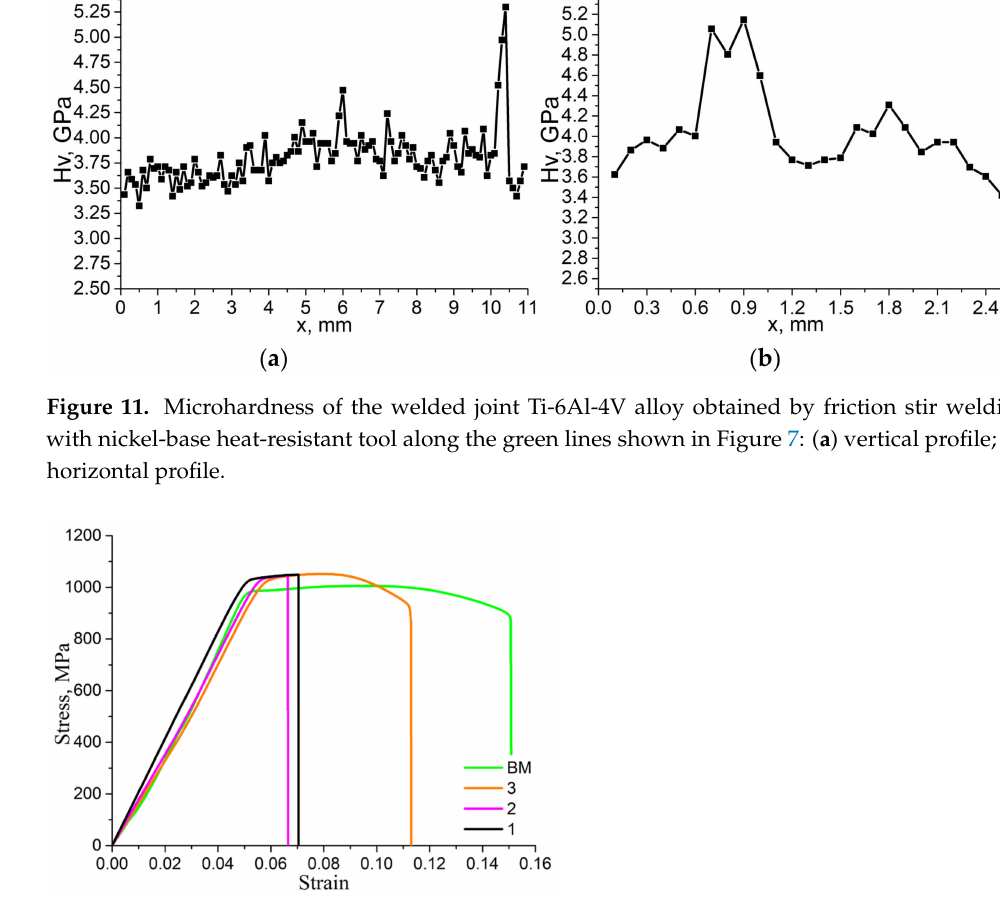
Figure 12. The tensile stress-strain curves obtained on samples 1, 2 and 3 produced with 340, 360 and 380 RPM rotation rates.